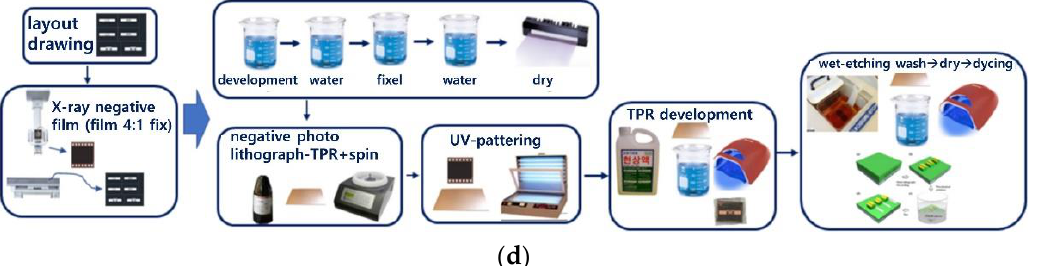
Figure 7. Structure of the proposed BPF: ( a ) SIR structure; ( b ) layout; ( c ) fabrication; and ( d ) fabri- cation process (wet etching).